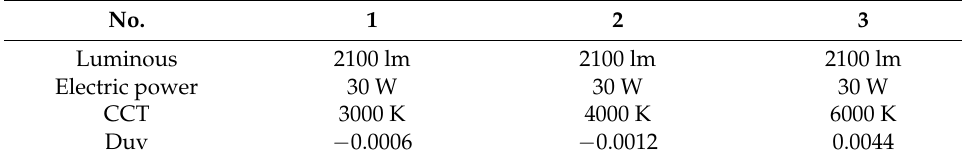
Table 1. Characteristics of light sources.